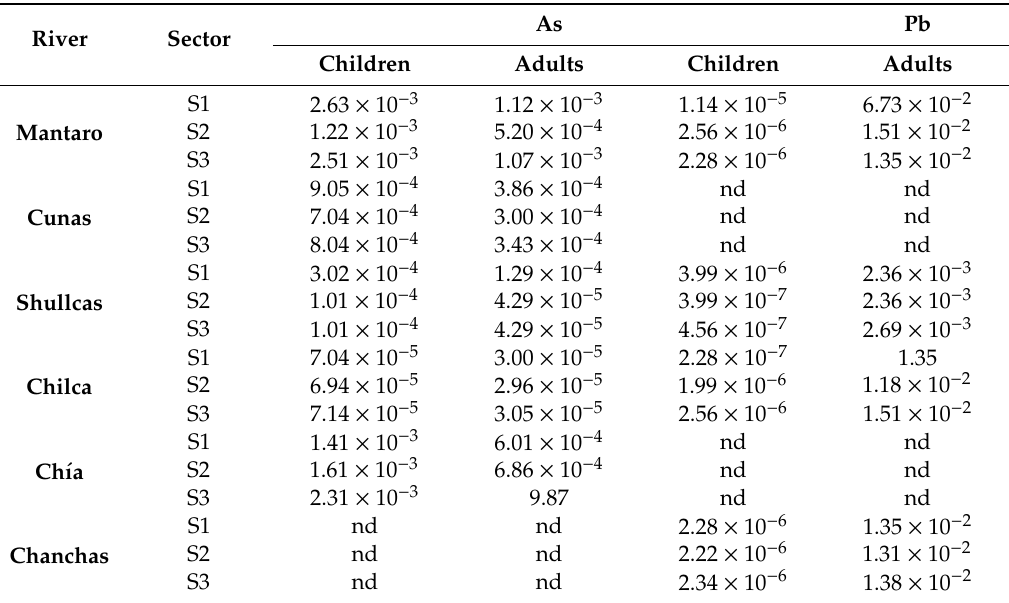
Table 5. Carcinogenic risk by ingestion arsenic and lead in river water subject to mining influence (children and